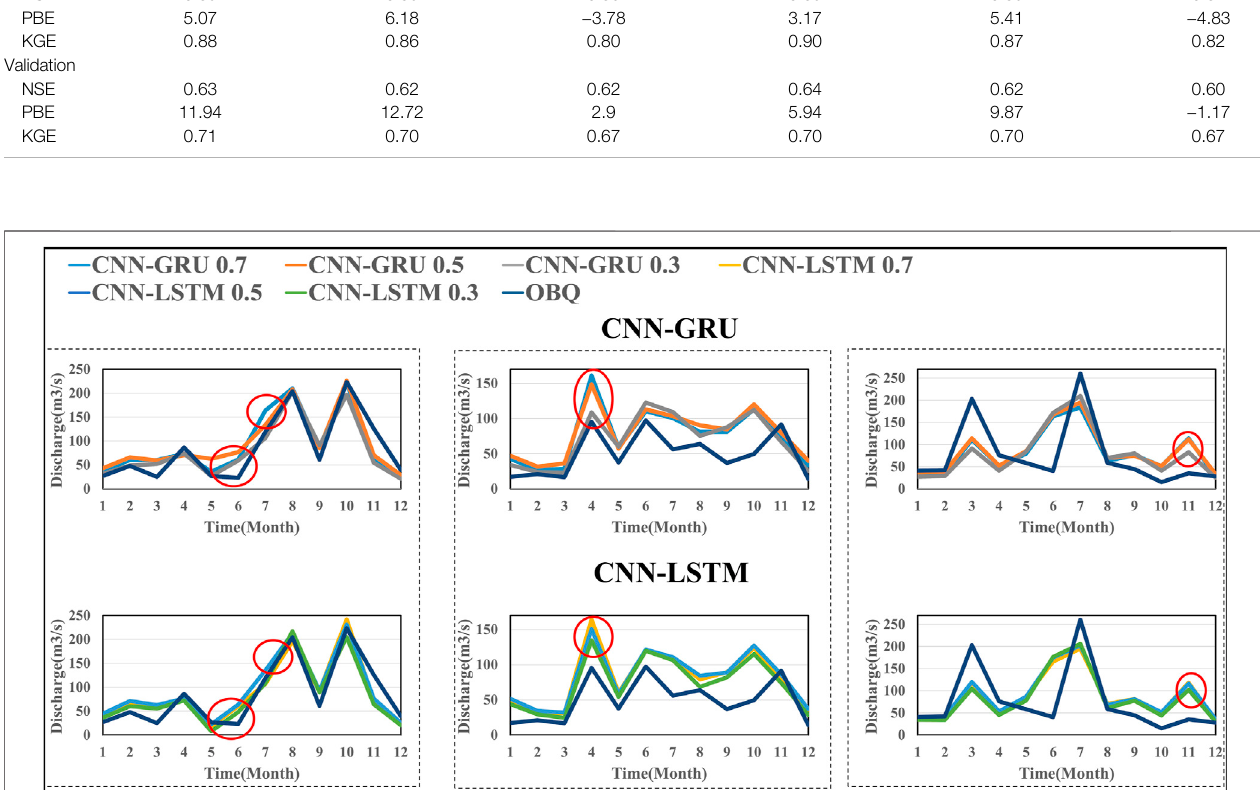
Frontiers in Earth Science |